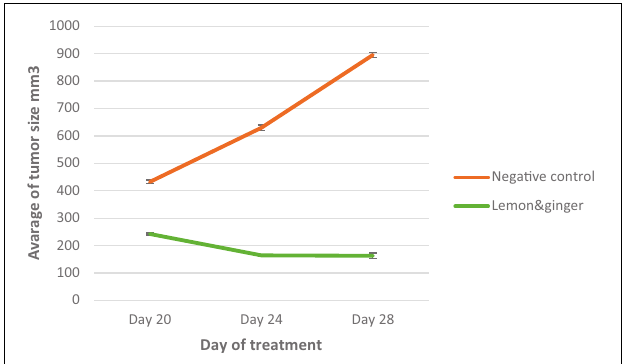
FIGURE 7 | A plot of change in average tumor size (mm 3 ) vs. time in (days of treatment in EMT-6/P cell line). *Significant values ( P -value = 0.05).